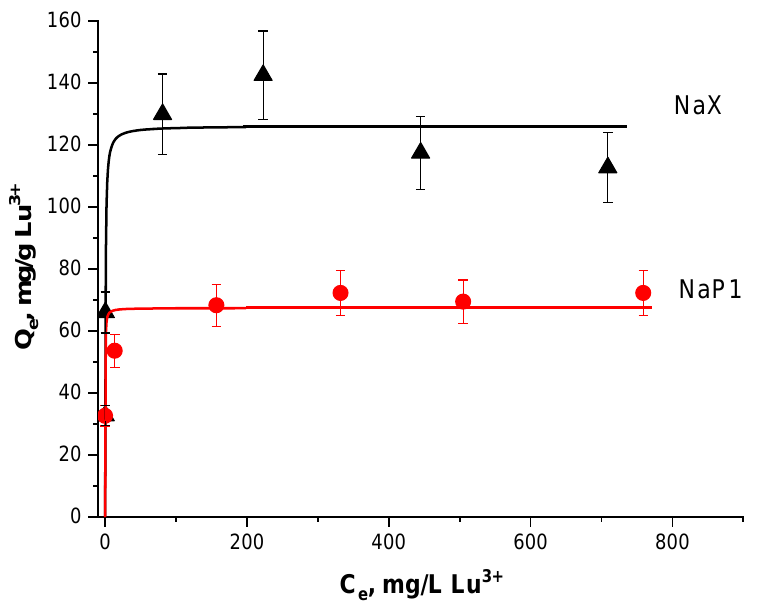
Figure 5. The Lu 3+ sorption on the NaX and NaP1 bearing microspheres at room temperature: points — experimental data; lines — guide for eyes.